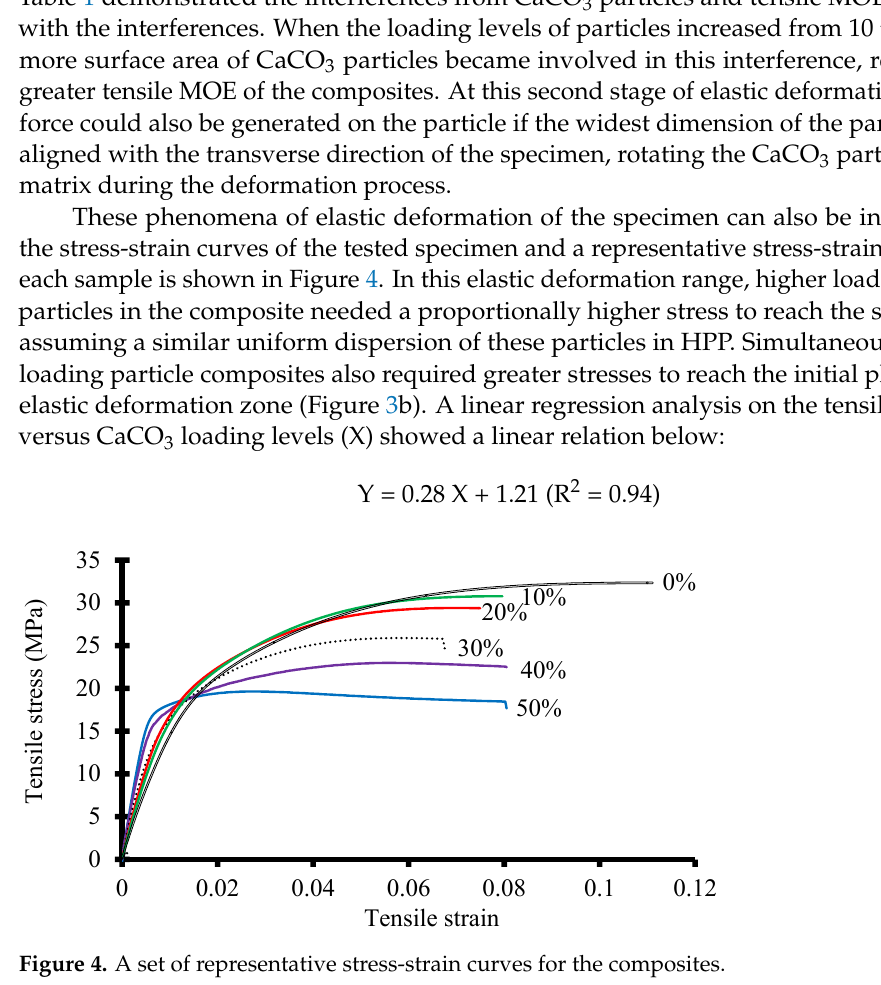
Figure 4. A set of representative stress-strain curves for the composites.